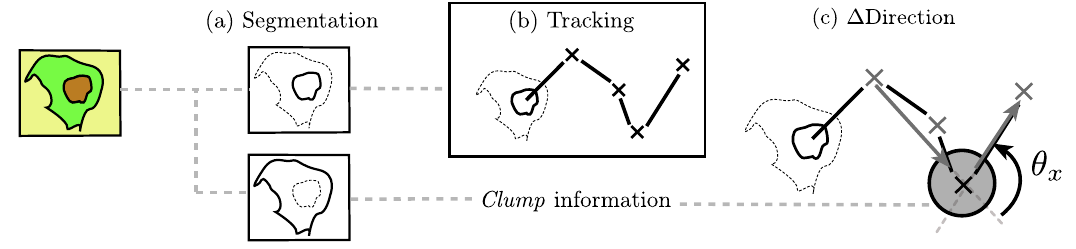
Figure 4. Graphical illustration of the analysis done in this work. Three principal phases are depicted. ( a ) Segmentation of each fluorescence channel; ( b ) Tracking of the red channel and identification of each clump . Each mark ( × ) in the diagram corresponds to a different time frame; ( c ) Finally, the measuring of the change of direction angle ( θ x ) before and after a detected clump